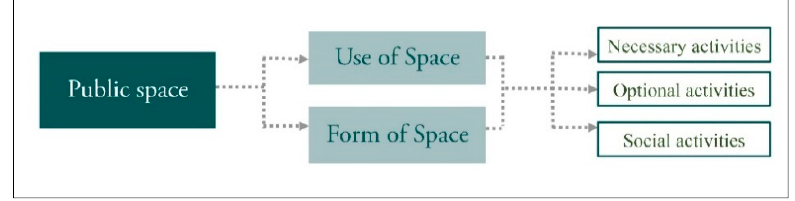
Figure 2. Types of public space (Source: Gehl, J. Adapted from [26,27].